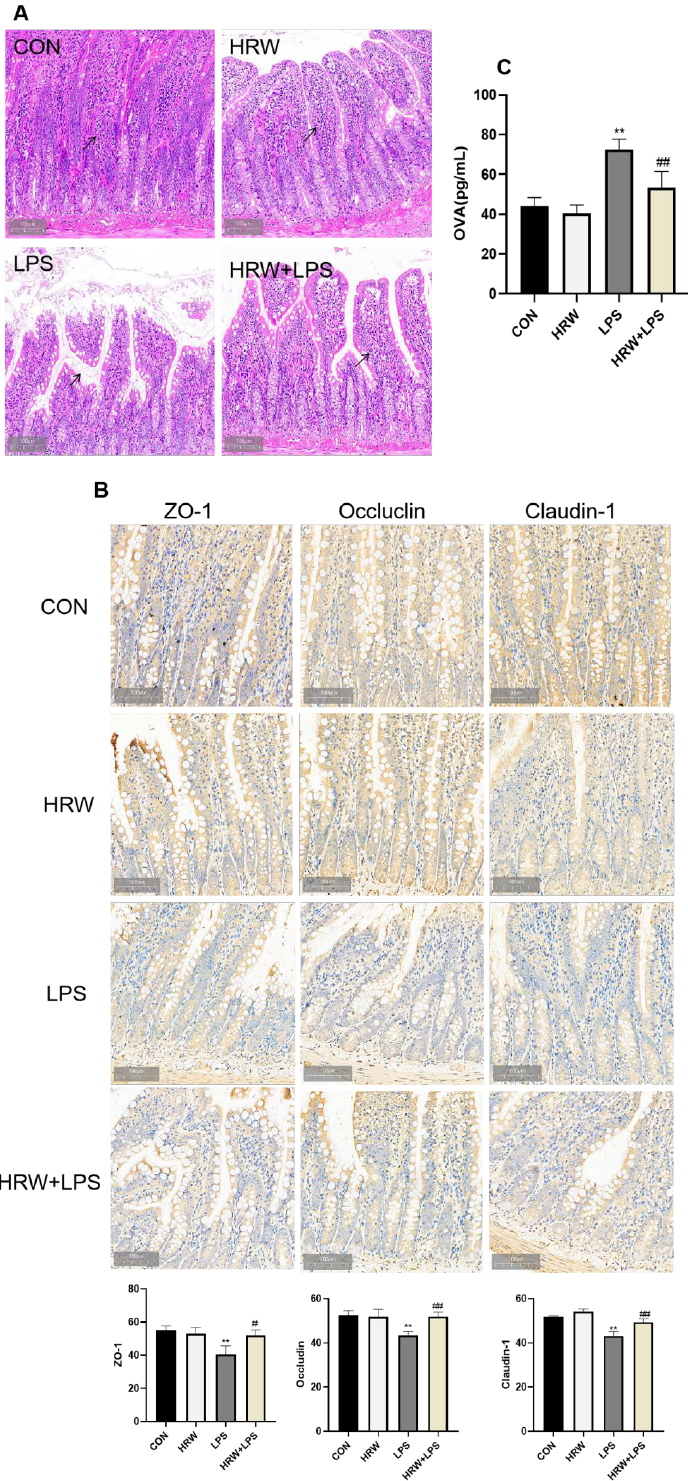
Figure 1. Effect of HRW on gut permeability. ( A ) Histopathological sections of rat ileum (150 × ). The black arrow indicates the villous state of the small intestine. ( B ) Immunohistochemical and quantitative analysis of ZO-1, occludin, and claudin-1 in ileal tissue. ( C ) OVA levels in the ileal tissue. # p < 0.05; **, ## p <